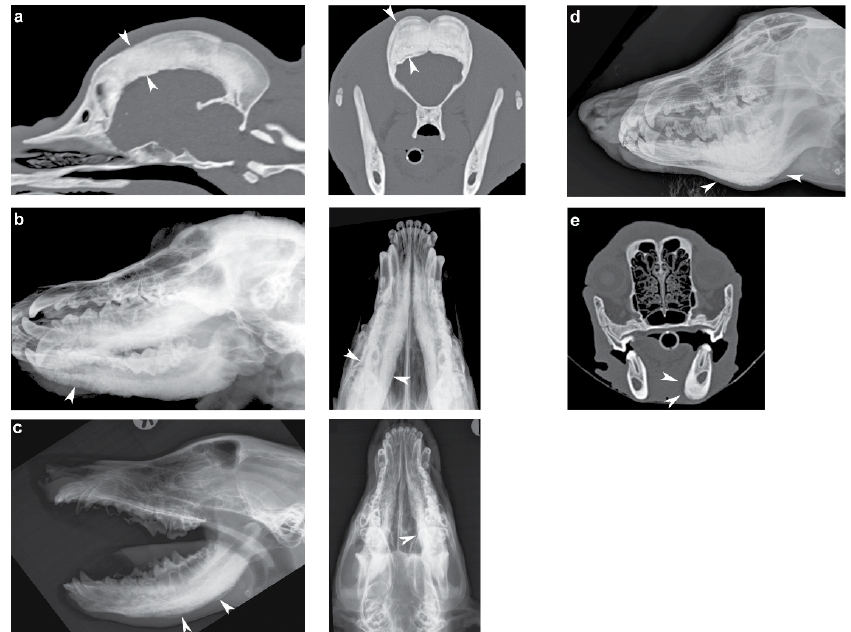
Figure 1. Radiographs / computed tomographic (CT) images of the craniomandibular osteopathy (CMO) / calvarial hyperostotic syndrome (CHS)-a ff ected dogs. ( a ) Sagittal and transverse CT images of an American Sta ff ordshire Terrier showing severe thickening of the calvarial diploic bone (arrowheads). ( b ) Ventrolateral-dorsolateral oblique and ventrodorsal skull radiographs illustrating a palisading periosteal new bone formation along the mandible of a Basset Hound (arrowheads). ( c ) Open mouth laterolateral and ventrodorsal view of the skull of a German Wirehaired Pointer showing periosteal new bone formation along the mandible (arrowheads). ( d ) Slightly oblique laterolateral view